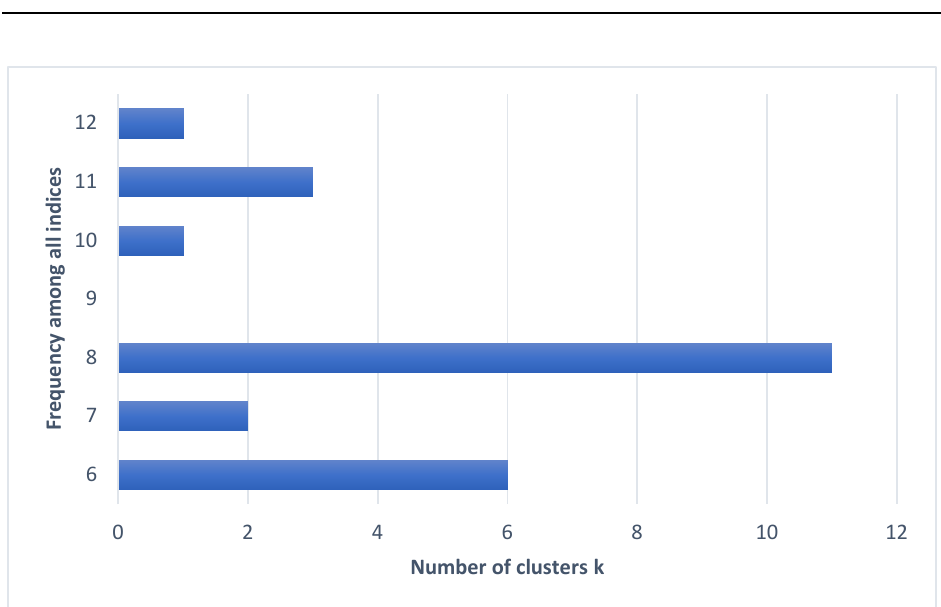
Figure 8. Summary of the Different Indices for Determining the Optimal Number of Segments.